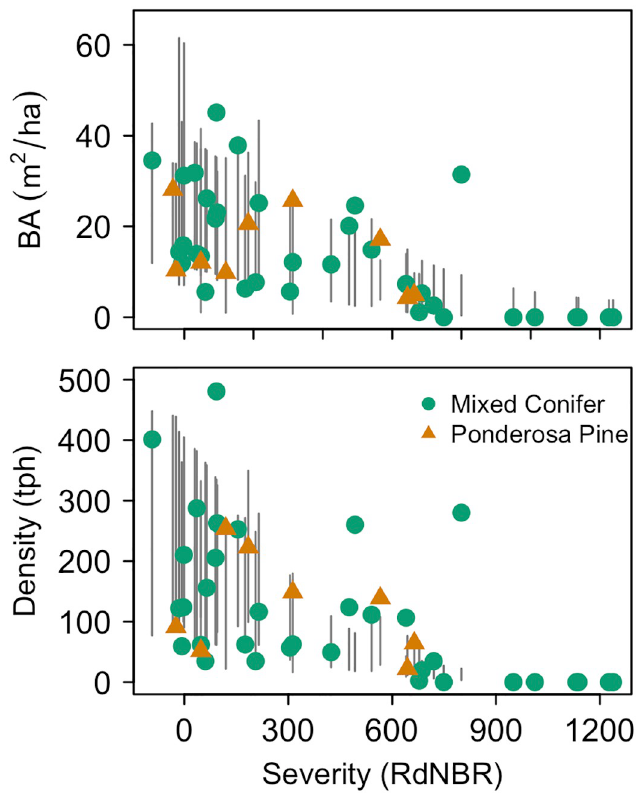
Fig 6. Stand basal area and density of plots used for model validation. Points for each plot are displayed on a vertical line representing the 95% confidence interval of modeled estimates for the nearest national forest and corresponding forest type and